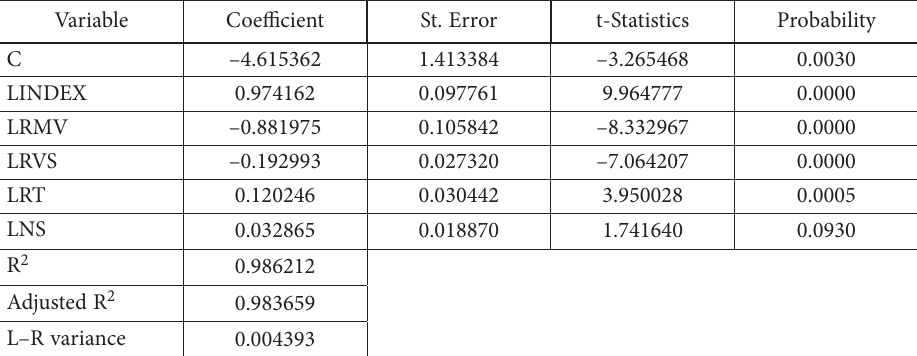
Table 6. FMOLS estimates with dependent variable